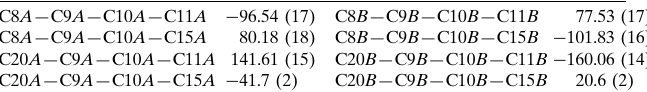
Selected torsion angles ( (cid:1) ).